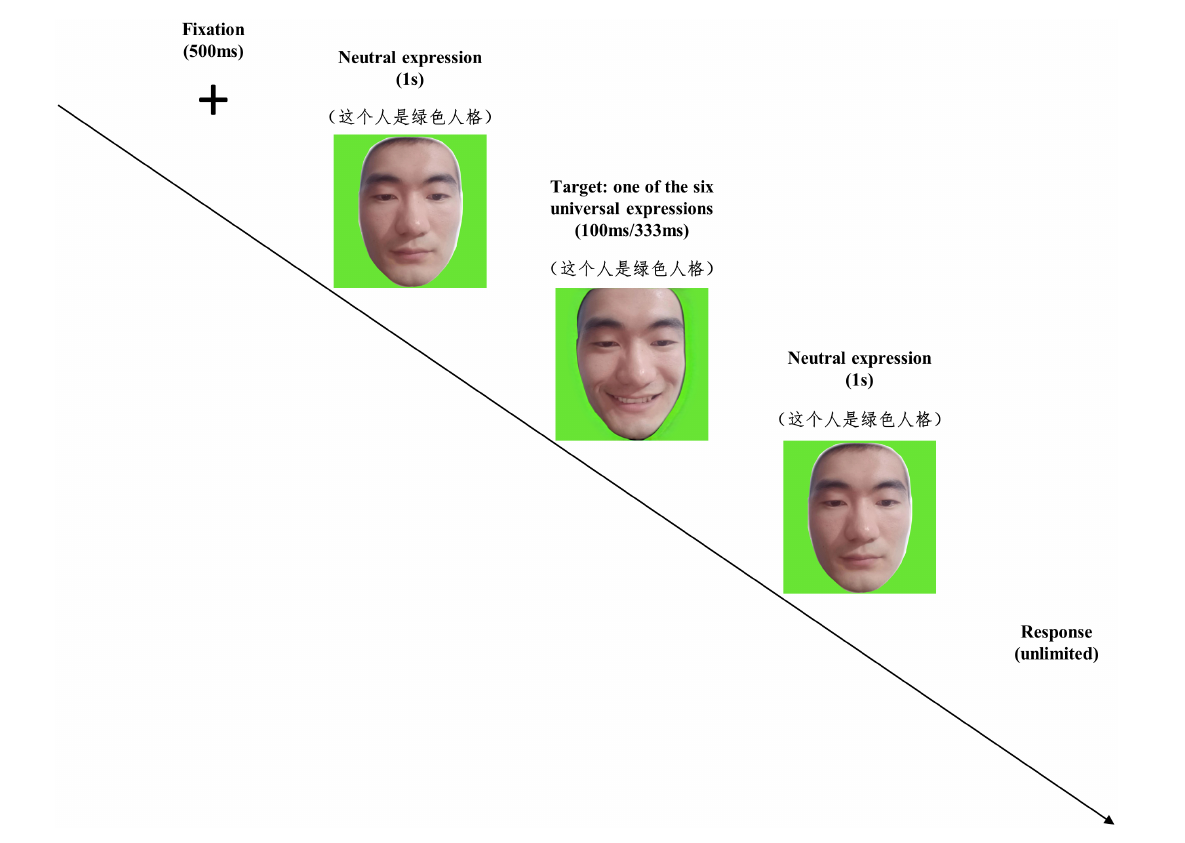
FIGURE 4 The procedure of the micro-expression recognition task in Study 1B. An example of target with green personality is presented. Note that we employ the facial images of the second author for illustration.